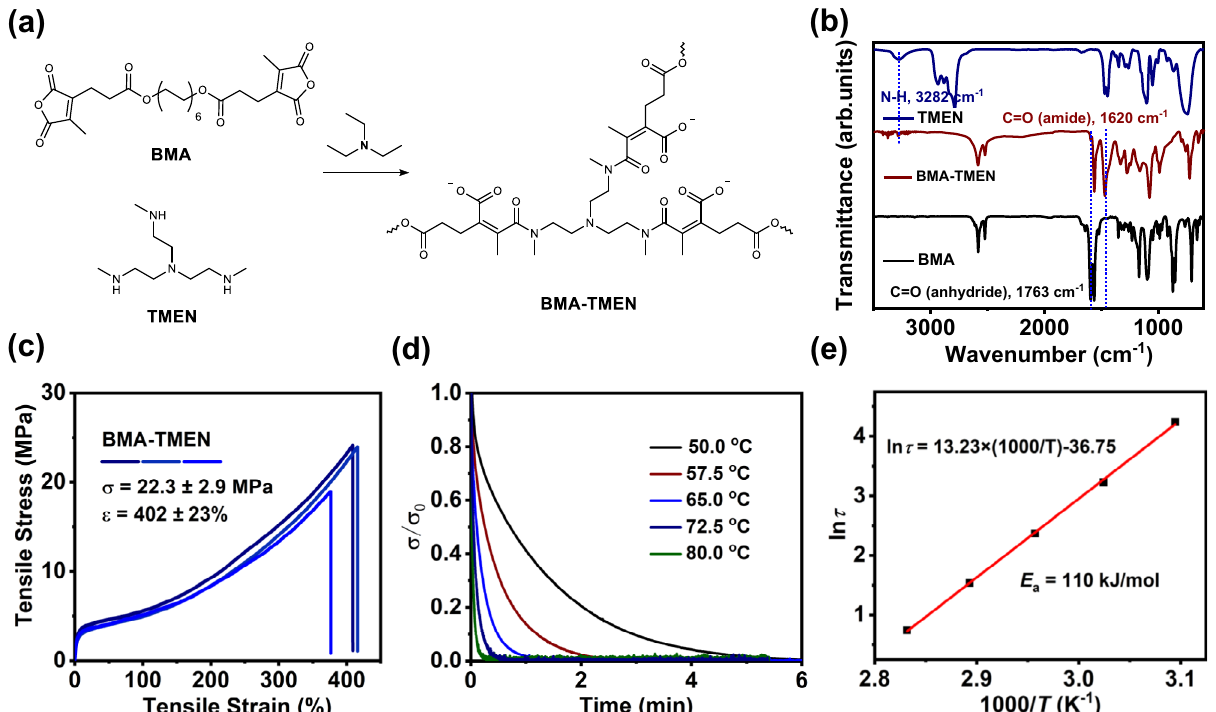
Fig.3|PreparationandcharacterizationofrubberyBMA-TMEN.a Schematicof the polymer network BMA-TMEN synthesized by the polycondensation of TMEN andBMAinthepresenceoftriethylamine. b FT-IRspectraofTMEN,BMA-TMENand